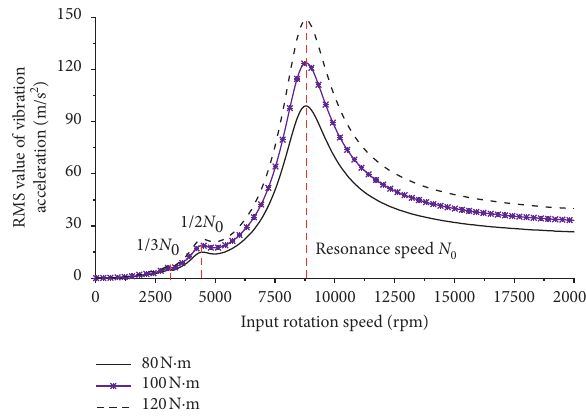
Figure 8: The vibration acceleration diagram of the single-stage gear system under excitation of TVMS.